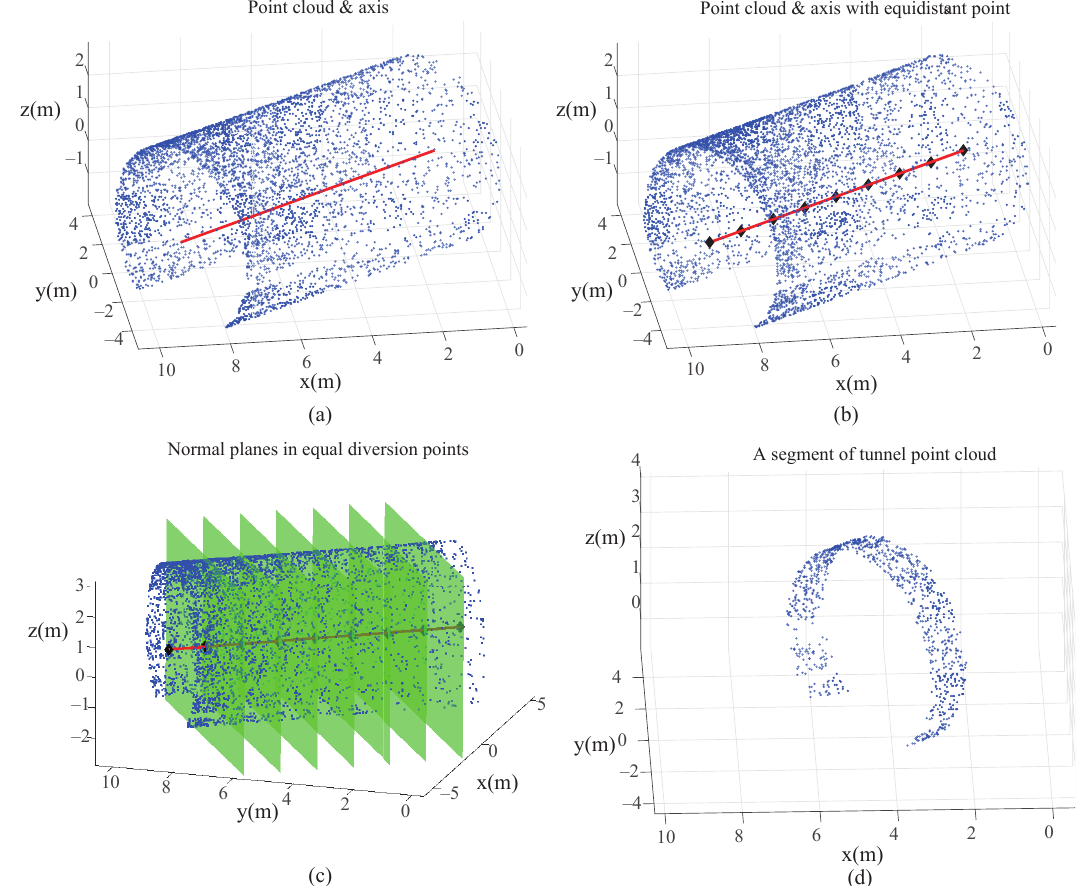
Figure 9. The procedure of tunnel point cloud segment extraction: ( a ) illustrates the tunnel point clouds with the axis; ( b ) illustrates the equal division in the axis of a section of a tunnel point cloud; ( c ) illustrates that the normal planes with equal division points divide the tunnel point clouds into lining segments; ( d ) illustrates the tunnel point cloud segment used for subsequent data